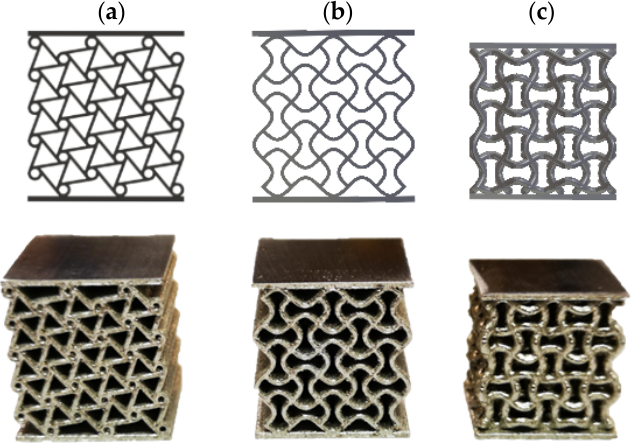
Figure 1. Visualisation of analysed geometries (first row) and image of tested specimens (second